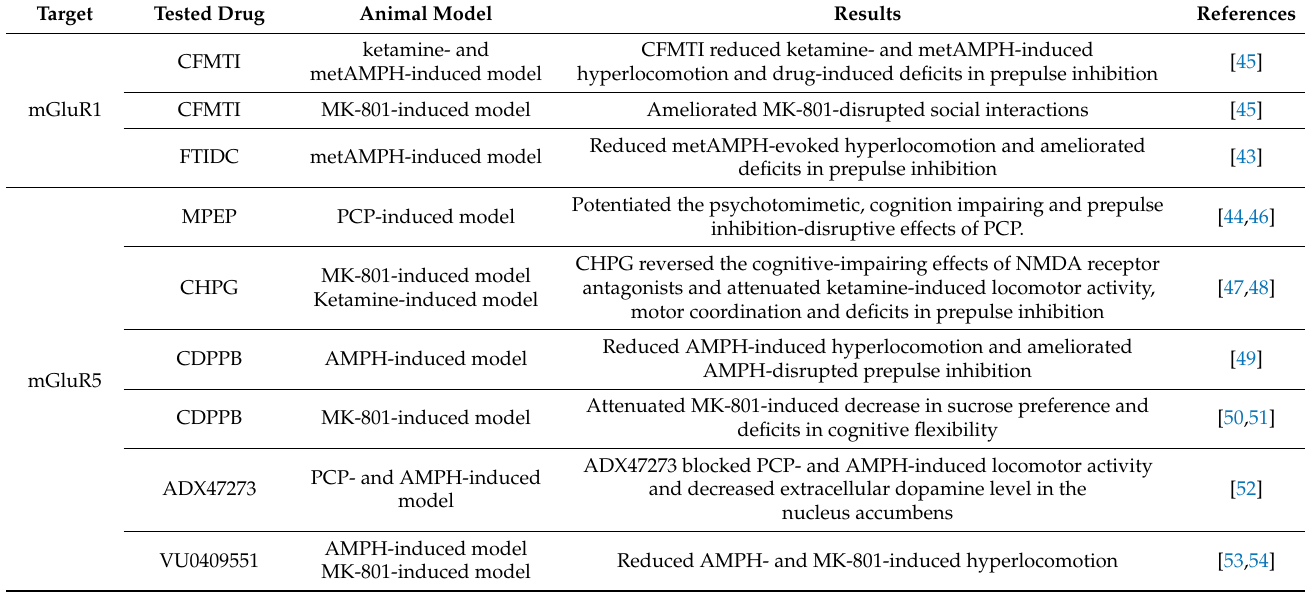
Table 2. Summary of the preclinical studies on mGluR1/5